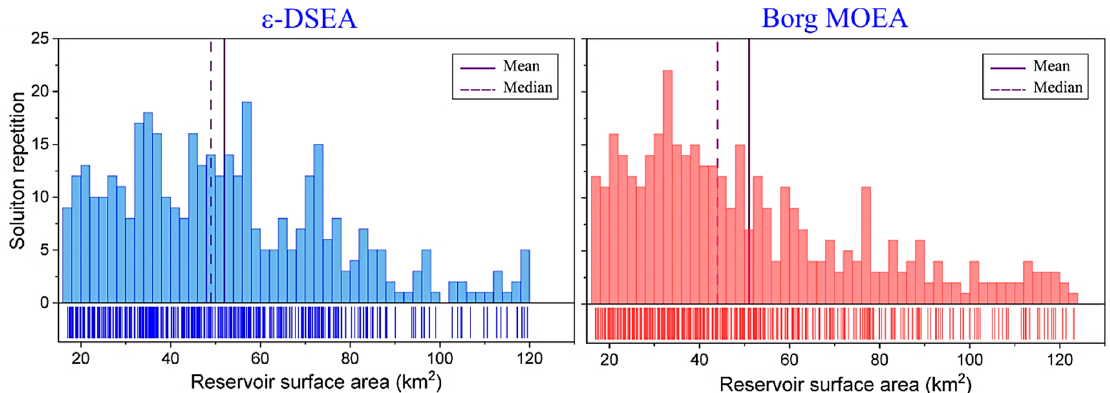
Figure 10. Reservoir’s surface area distribution achieved by both algorithms under f summerD